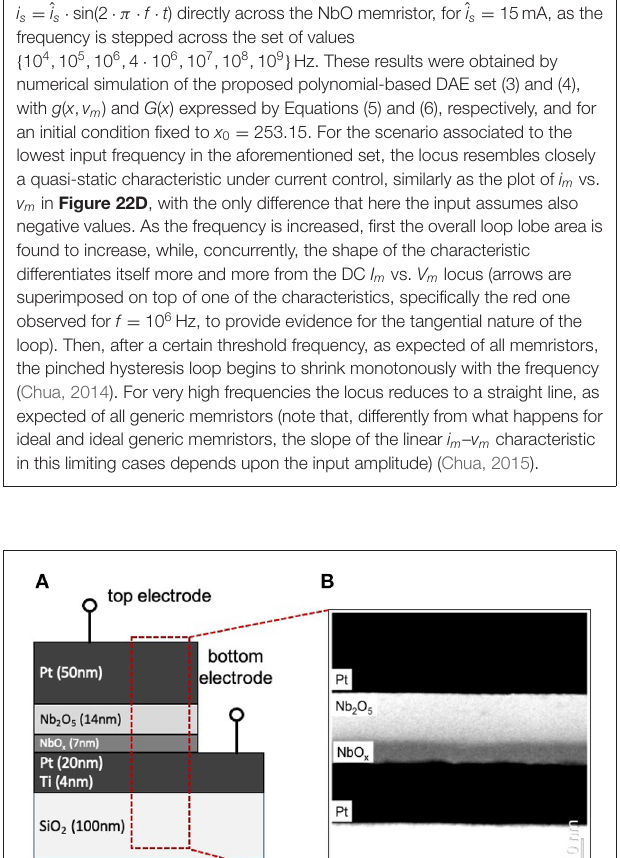
FIGURE 24 | Schematics (A) and TEM image of the micro-device stack (B) .